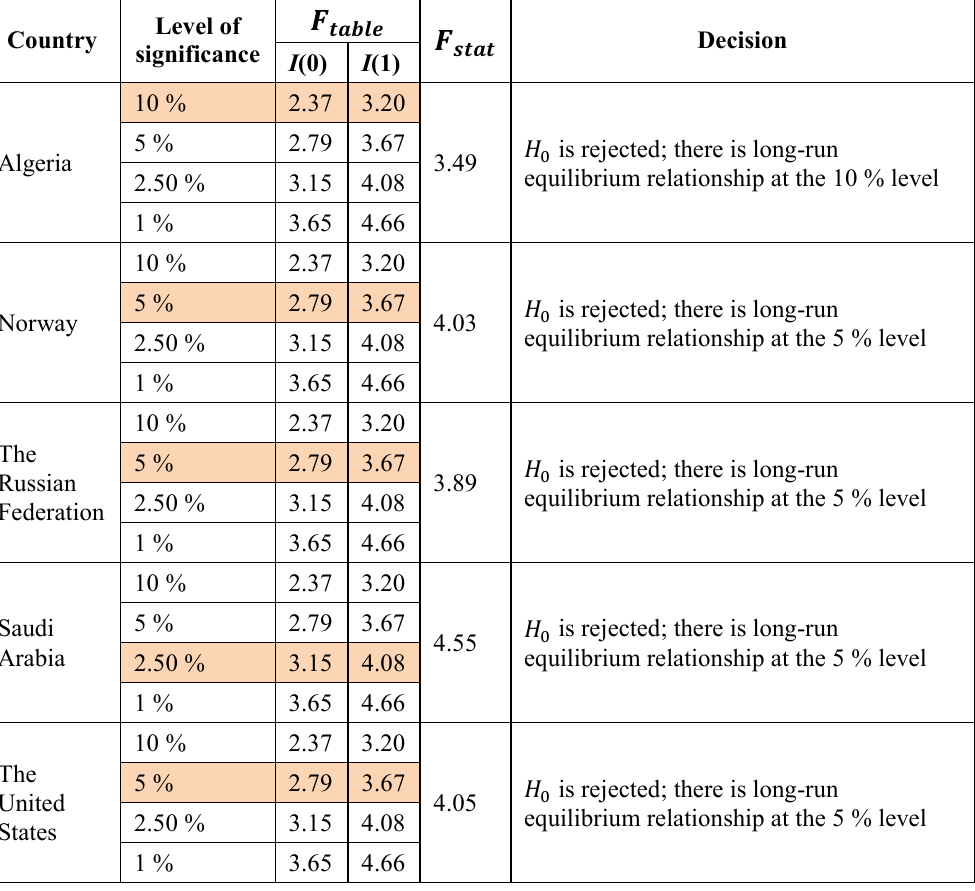
Table 6. The Bound Test for